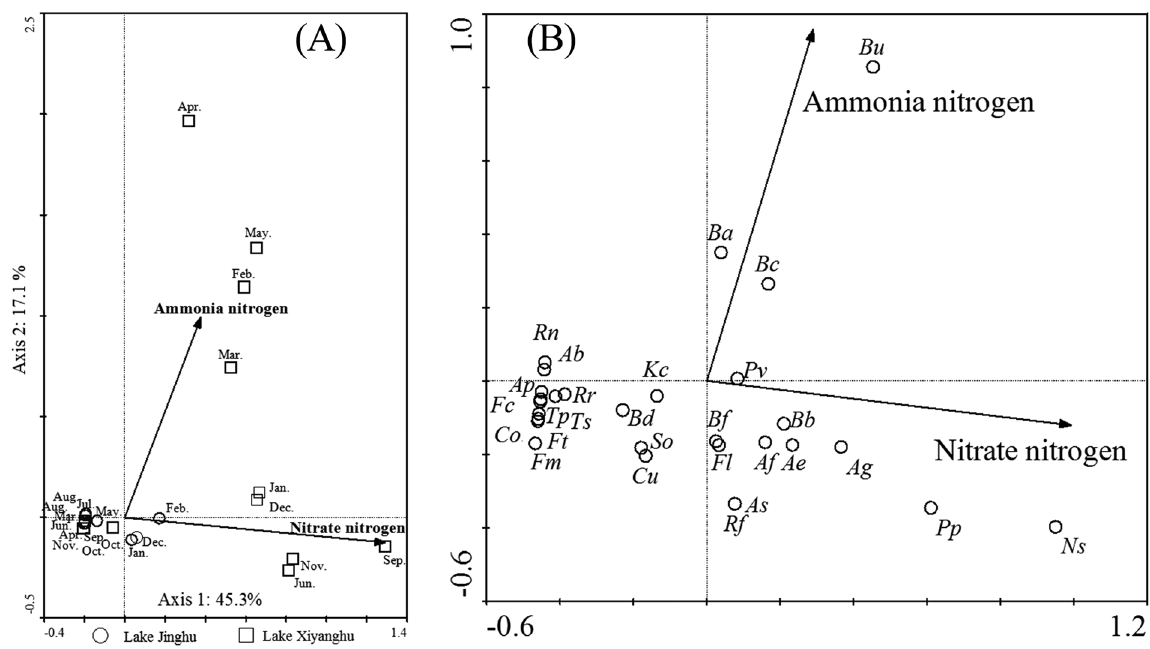
Figure 2. RDA ordination biplots of the site scores ( A ), species composition ( B ), and selected environmental variables in Lake Jinghu and Lake Xiyanghu. (Ammonia nitrogen = NH 4 + -N; Nitrate nitrogen = NO 3 −